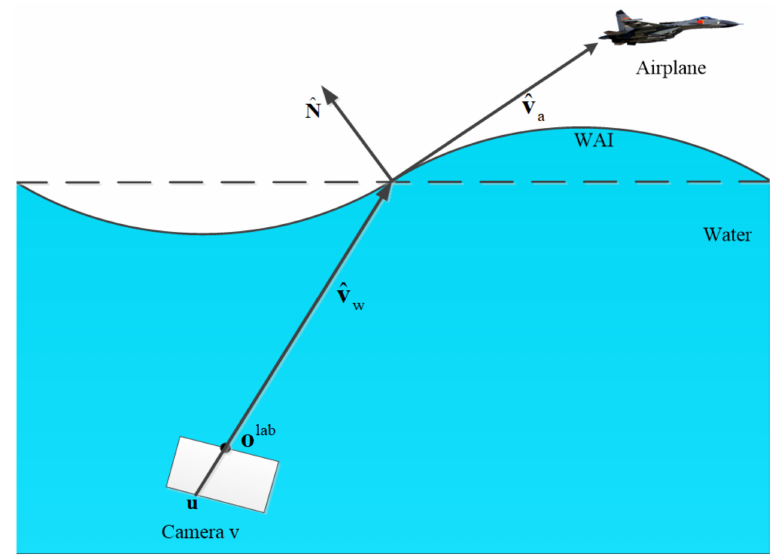
Figure 7. The principle of reverse ray